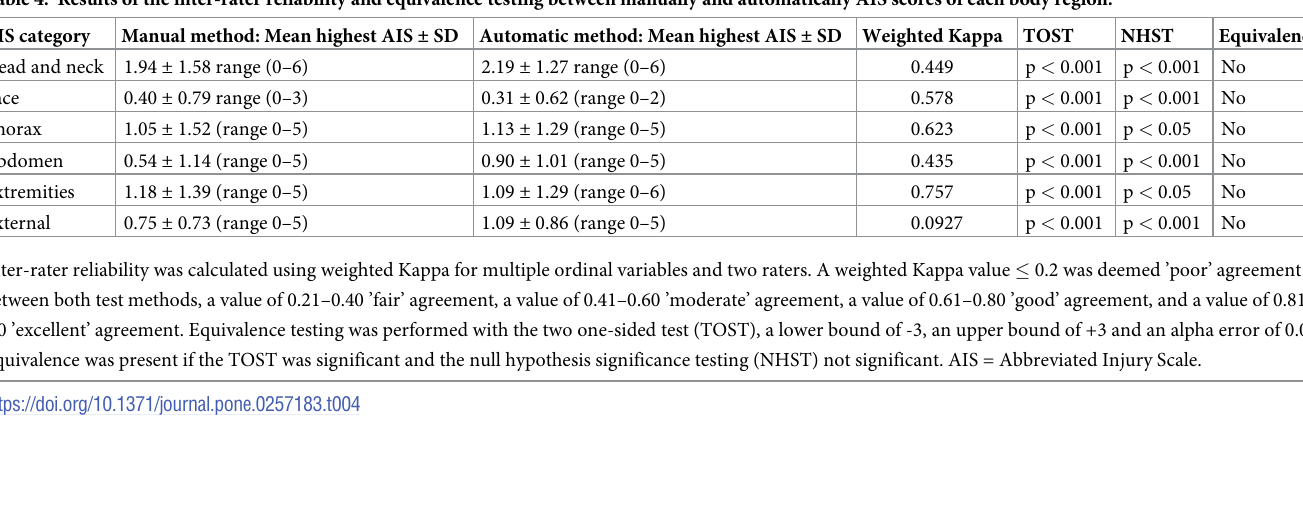
Overall, weighted Kappa was 0.47, which was deemed a ’moderate’ agreement between both methods. ISS = Injury severity score.